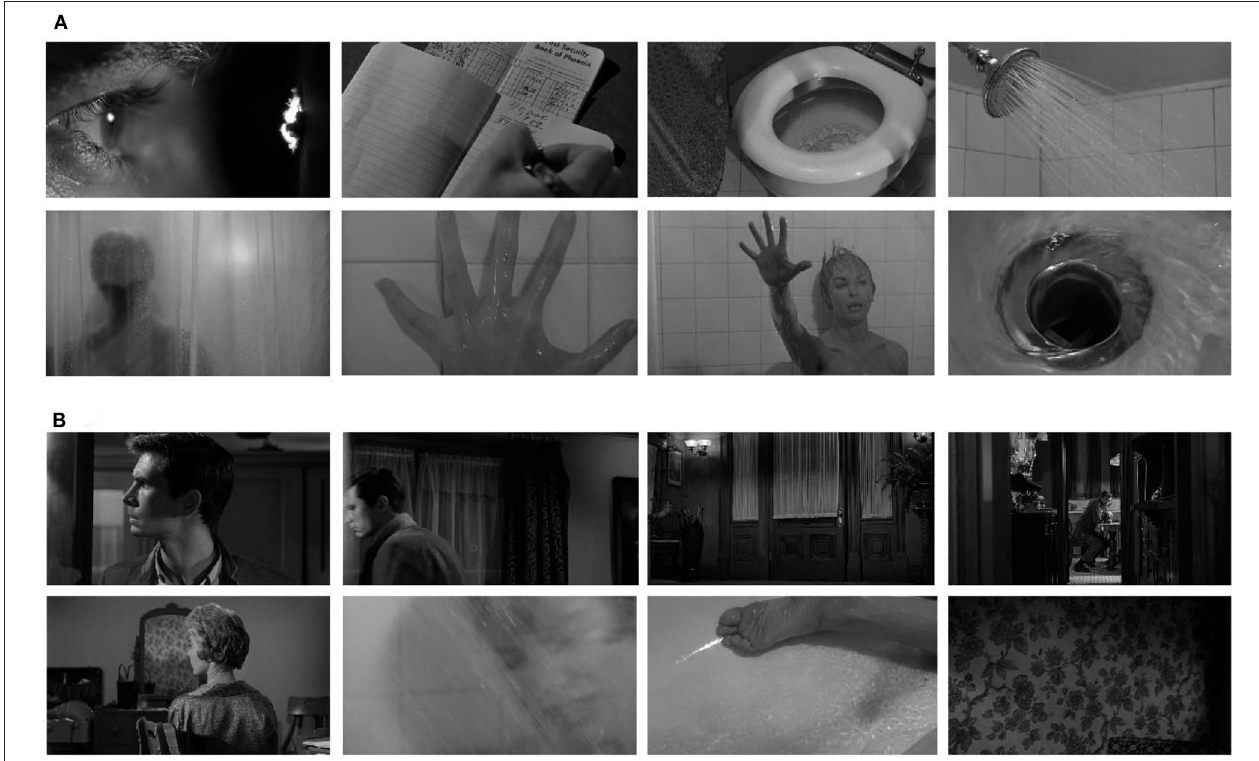
FIGURE 11 | (A) Images with 100% accuracy in the memory test. (B) Images with the lowest memory accuracy scores. Statistical significance tests have been performed on the high-value and low-value data, and p < 0.05.